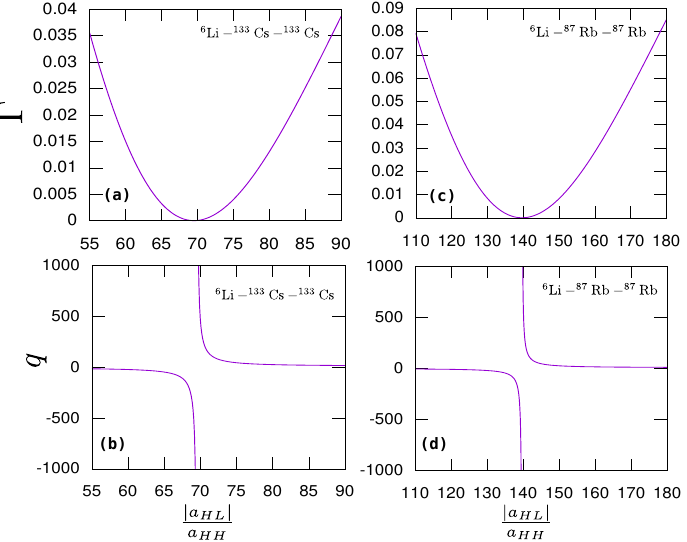
Figure 8. Panels ( a – d ) show the width of the Efimov resonance Γ and the asymmetry parameter q ∣ a HL ∣ versus the scattering length ratio for the 6 Li- 133 Cs- 133 Cs ( 6 Li- 87 Rb- 87 Rb) system, respectively. a HH Note that the total colliding energy is set to zero. Moreover, Γ and q are obtained via Equations (17) and (18), respectively, using the universal parameters shown in Table